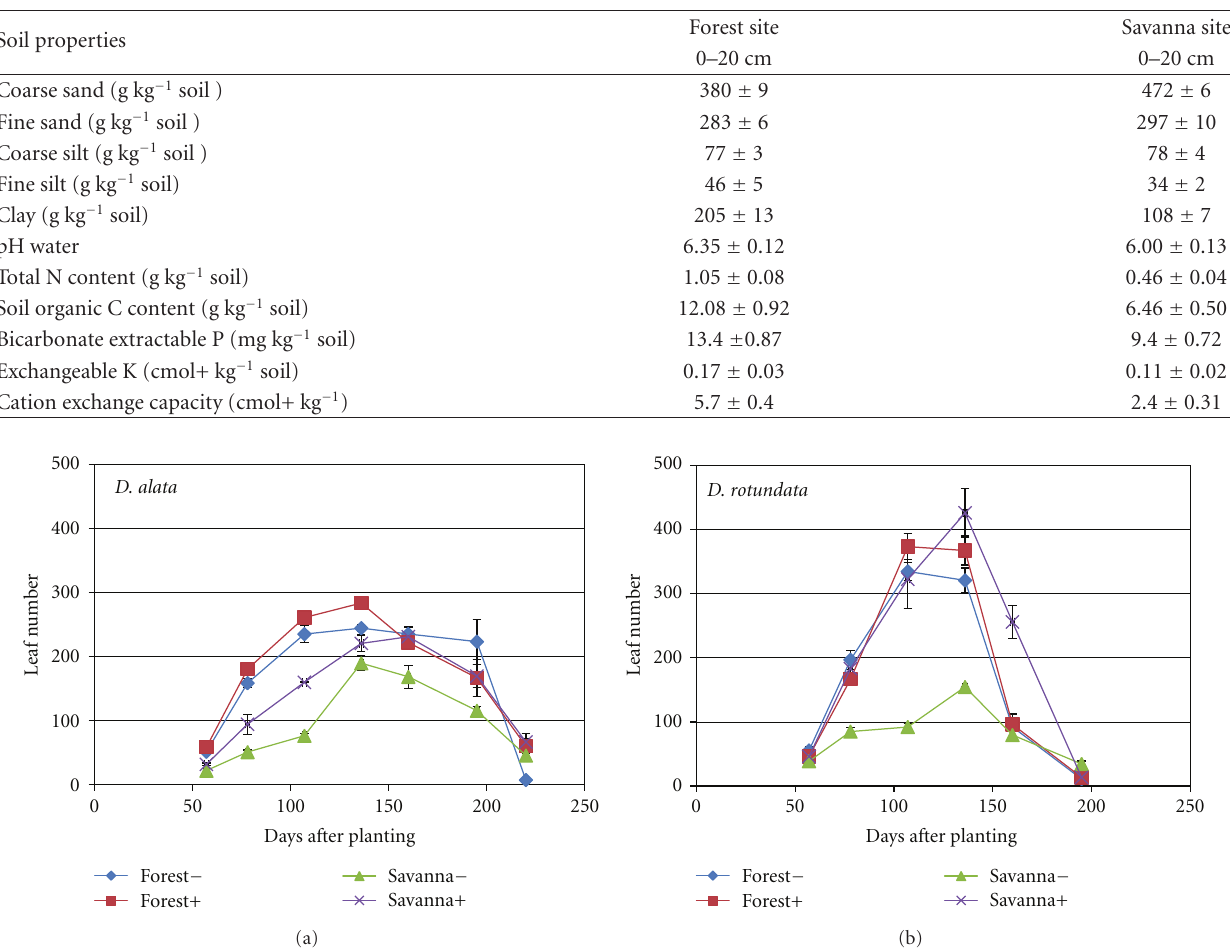
Table 1: Mean values ± standard errors of selected soil parameters (0–20 cm) of the forest and savanna sites.